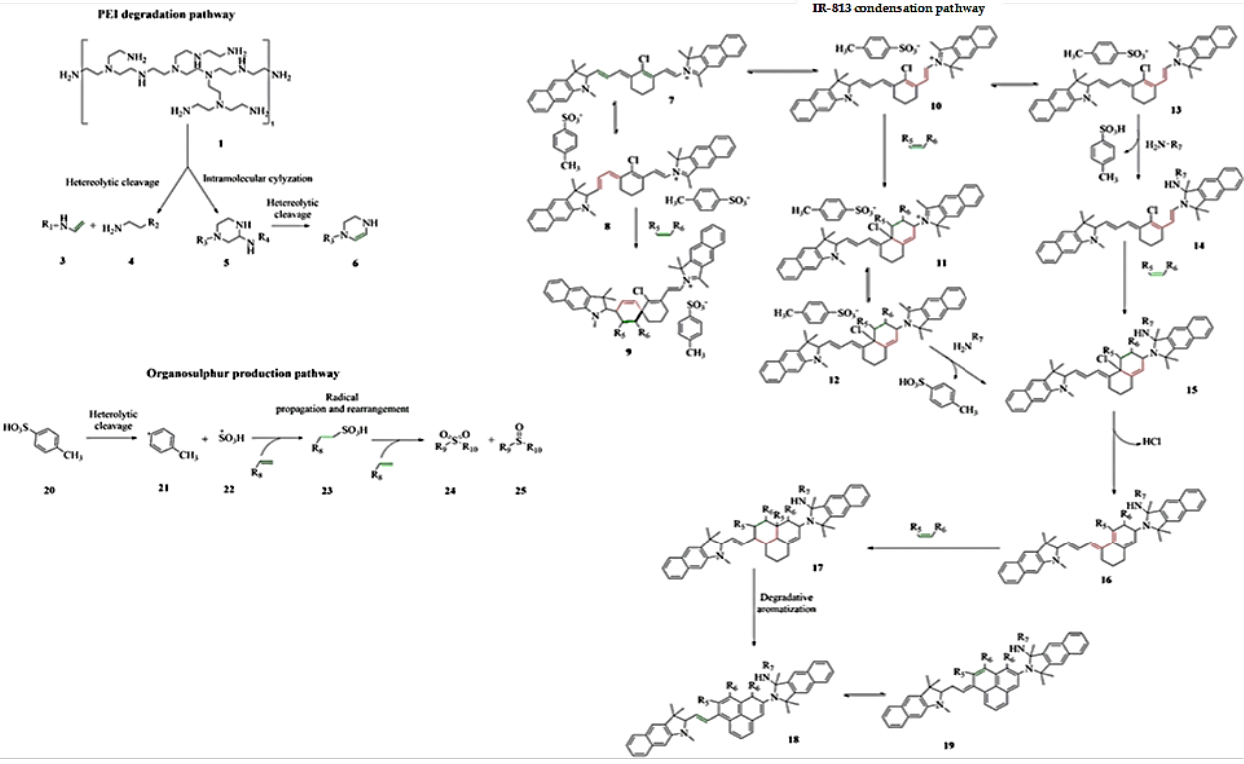
Figure 7. Formation mechanism of 813-CDs.